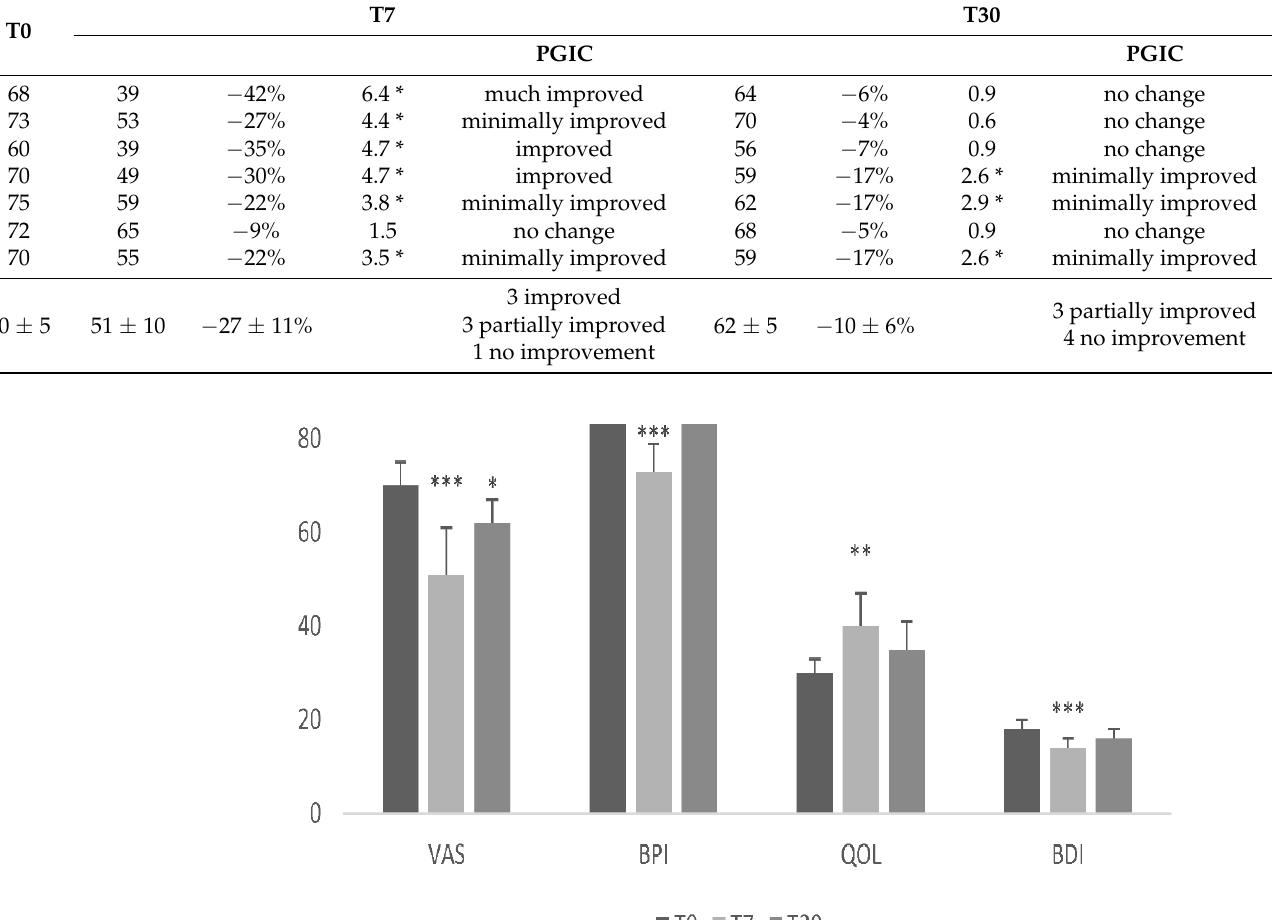
Figure 2. Average values of the outcome measures. Data are reported as mean with standard deviation; * indicates a significant T7-T0 or T30-T0 change (*** p < 0.001; ** p < 0.01; * p < 0.05). Legend: